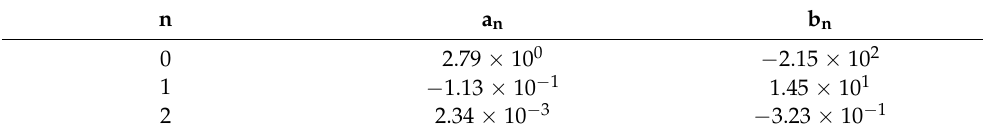
Table A25. Coefficients of the H 2 O-LiI saturated temperature